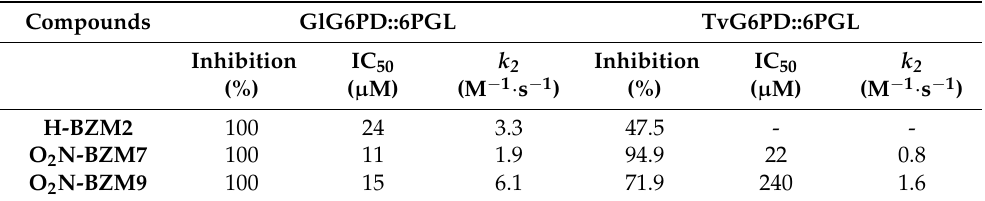
Table 2. Summary of inhibition, IC 50 values, and second-order rate constant values of inactivation ( k 2 ) of the compounds analyzed in this